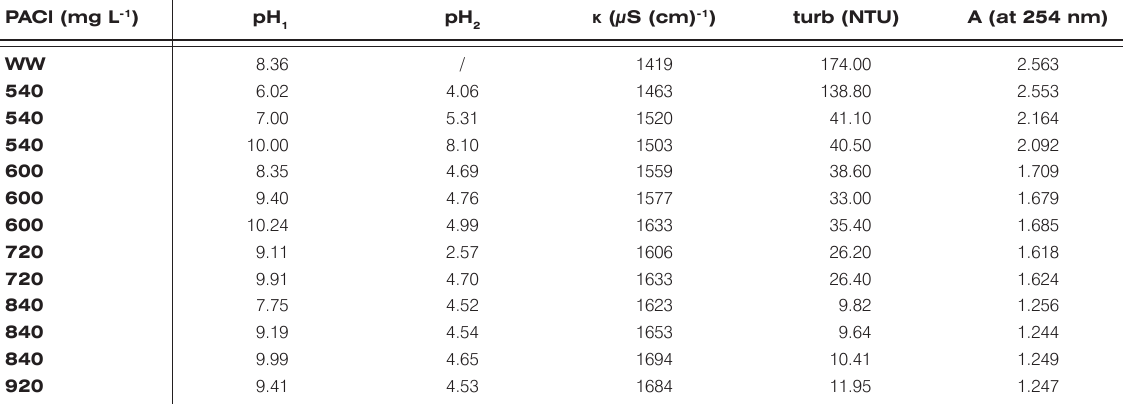
Table 2. Results after different PACl amounts were added into the